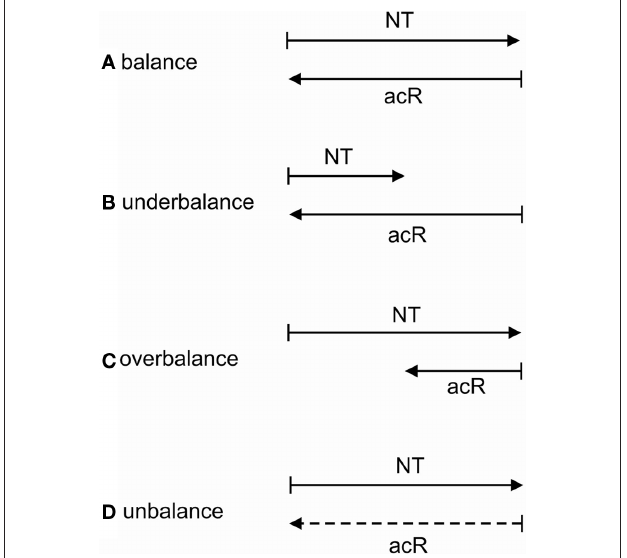
Figure 8 | Balance, underbalance, overbalance, and unbalance between neurotransmitters (NT) and astrocytic receptors (acr). Here, NT are interpreted as values and acR as variables. In the case where the amount of NT and acR is equal, the synaptic system is balanced (A) . If the number of acR surpasses the amount of NT available, the system is underbalanced (B) . In the inverse situation, the synaptic glial–neuronal interaction is overbalanced (C) . An unbalanced synaptic neurotransmission occurs if acR are non-functional (dashed line) for occupancy with NT (D)